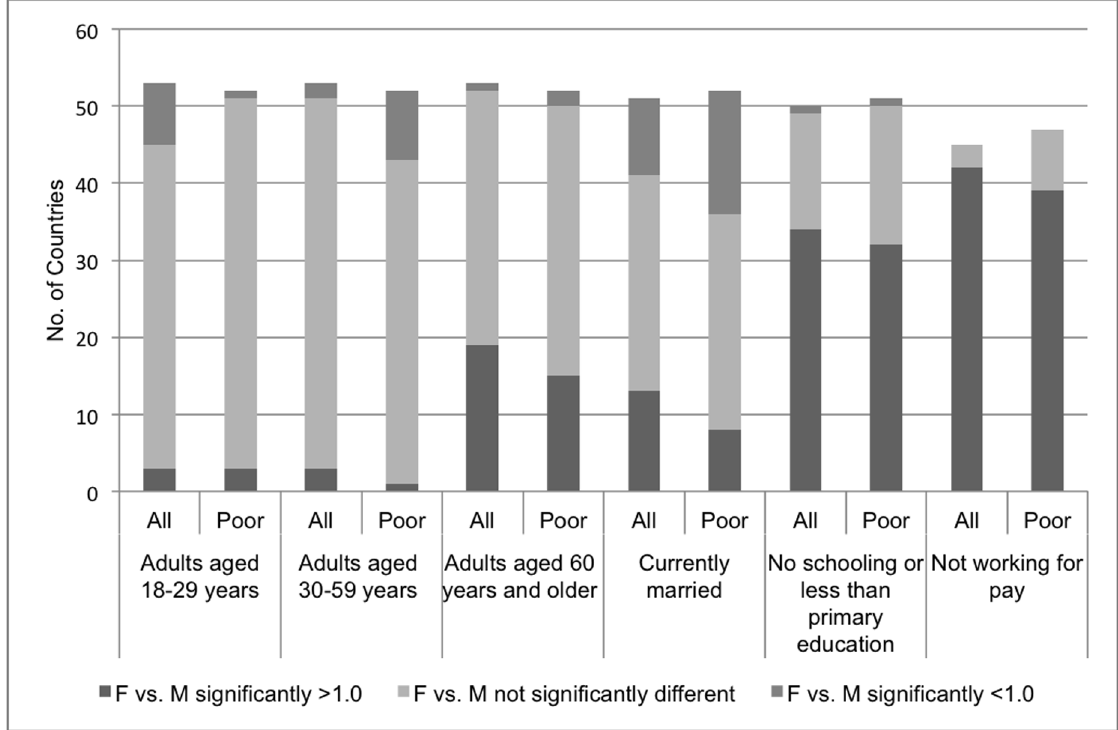
Figure 1. Adult demographics, number of countries with significant gender differences, all versus poor households.